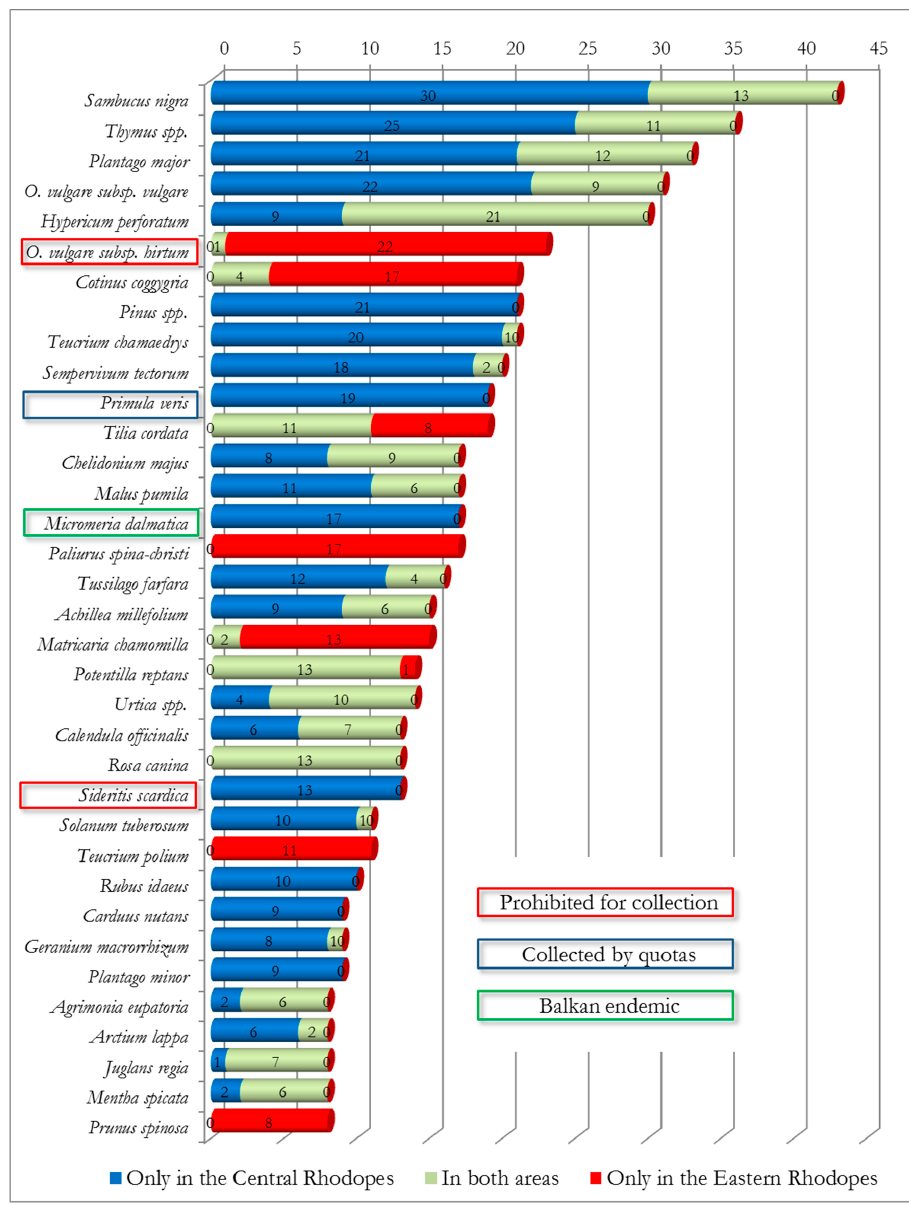
Figure 9. Most often mentioned species for most applications according to Σ U.